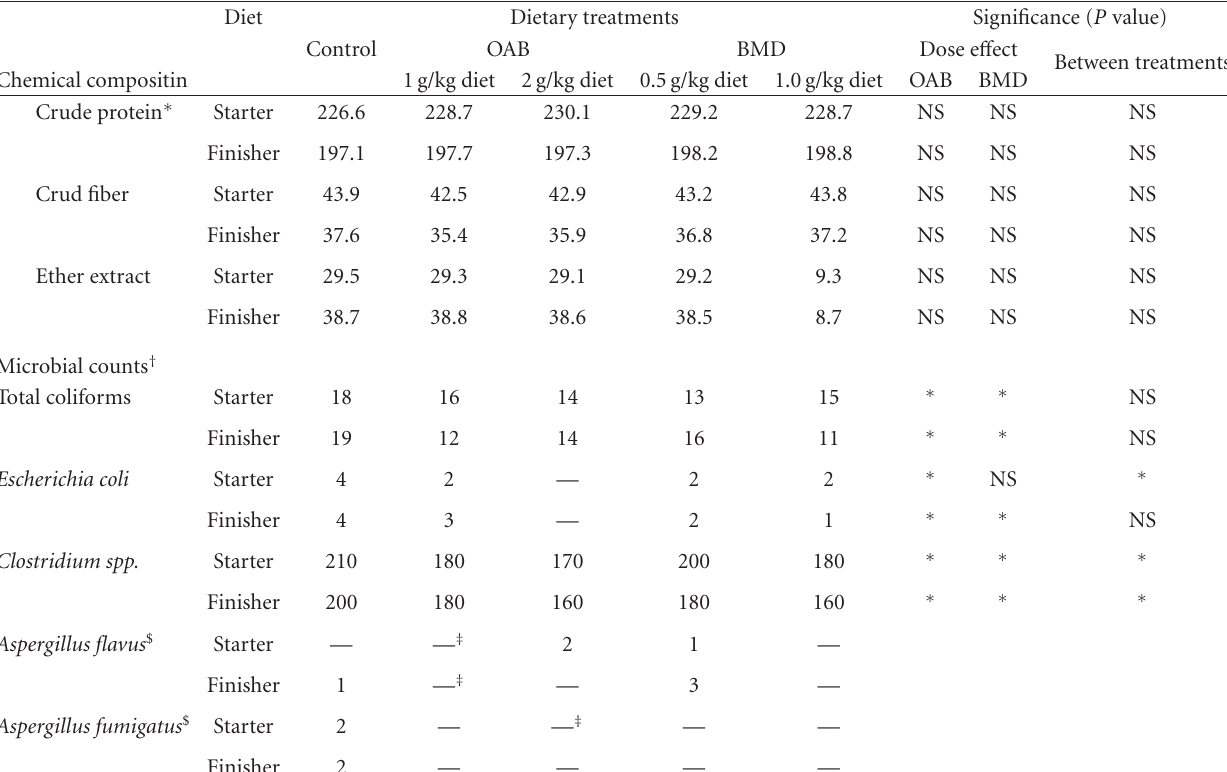
Table 2: Chemical composition (g/kg) and microbiological count (log acid blend (OAB) and bacitracin methylene disalicylate (BMD).